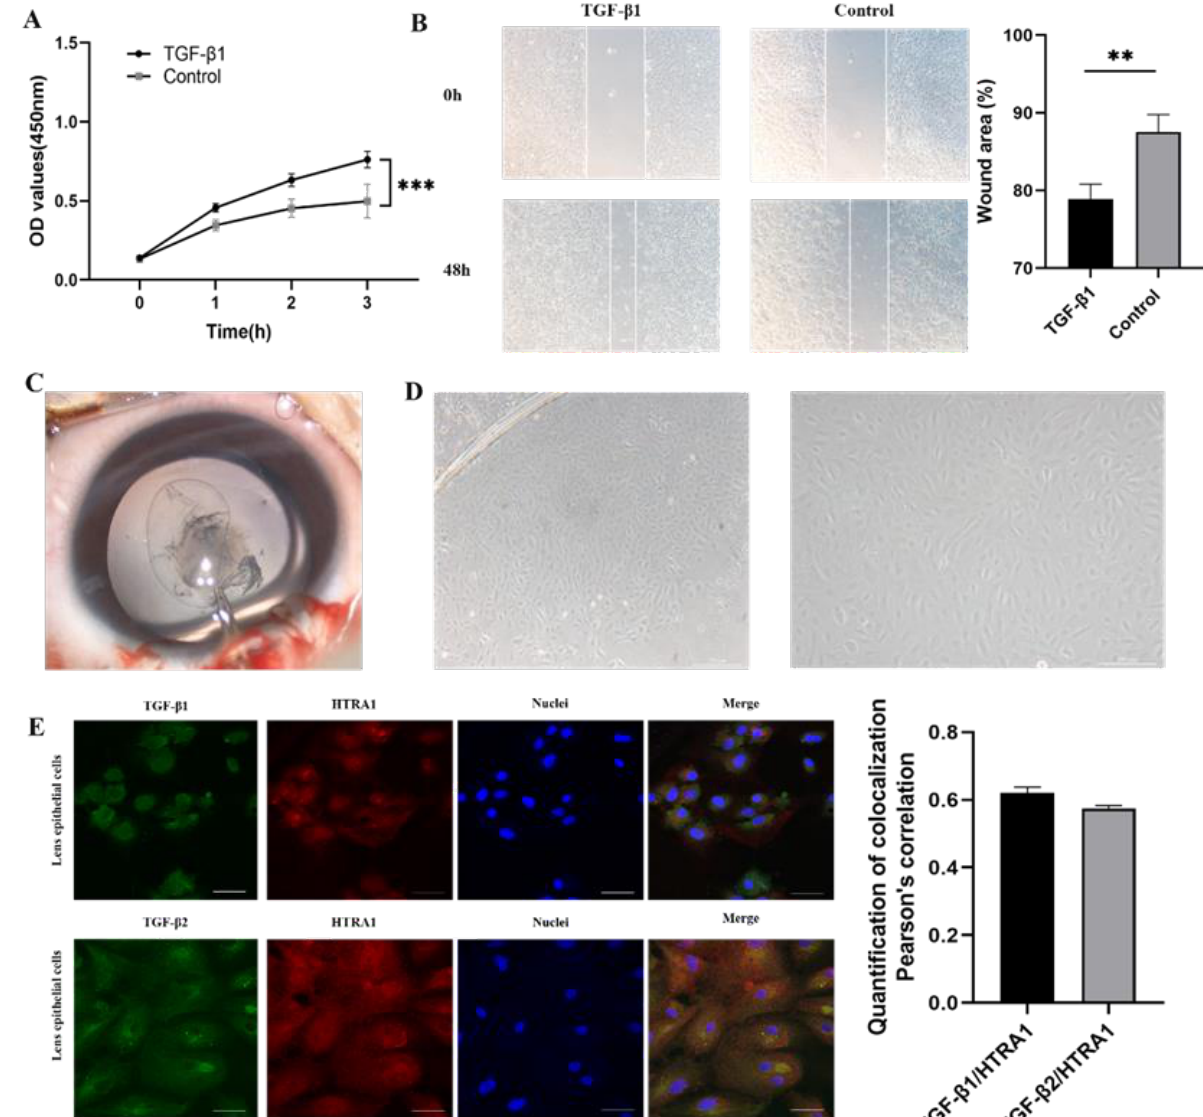
Figure 6. Elevated proliferation and migration of lens epithelial cells by TGF- β 1 and the colocalization between HTRA1 and TGF- β 1, as well as TGF- β 2. ( A ) CCK-8 assay of human lens epithelial cells after TGF- β 1 treatment ( p < 0.001). ( B ) Scratch healing assay of human lens epithelial cells after TGF- β 1 treatment (24 h, p = 0.007). ( C ) Anterior lens capsules were obtained via capsulorhexis during cataract surgery. ( D ) Cultured primary lens epithelial cells showed migration from the rim of lens capsules. ( E ) Immunofluorescence images of HTRA1, TGF- β 1, and TGF- β 2 staining. The amount of colocalization was analysed. ** p < 0.01, *** p < 0.001, Scale bar: 20 μm.